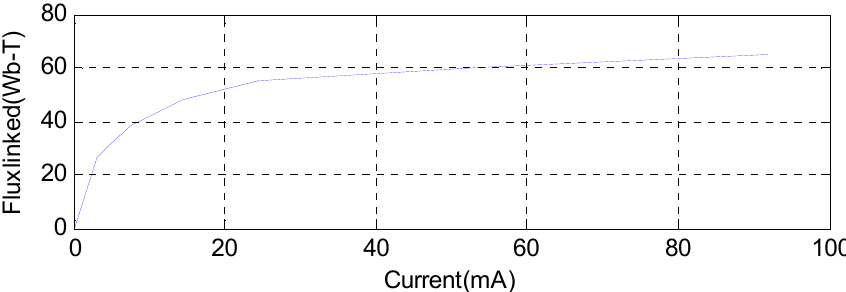
Figure 8. Excitation curve of PT’s nonlinear